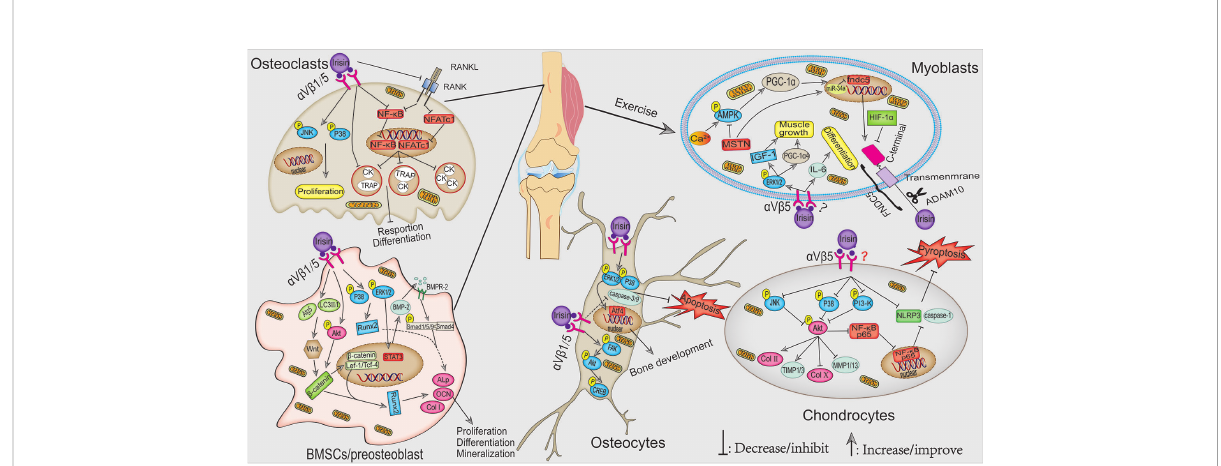
FIGURE 1 Potential mechanisms signaling pathways for the actions of irisin in musculoskeletal. During exercise, the elevated Ca 2+ in muscle cytoplasm- induced activation of the AMPK – PGC-1 a – FNDC5 axis is the main pathway for irisin synthesis. In addition, irisin, in turn, can stimulate muscle growth and myoblast differentiation via ERK1/2 – IGF-1/MSTN and IL-6 signaling pathways, respectively. Multiple pathways mediated exercise- induced irisin and r-irisin – activated osteoblast differentiation and mineralization, e.g., p38/ERK1/2, Akt- b -catenin, and Wnt- b -catenin – mediated activation of ALP/OCN/Col I pathways. In osteoclast, irisin induced its proliferation through activating the p38/JNK pathway. In addition, irisin also inhibited the NF- k B and NFATc1 levels in the nucleus, thus inhibiting the expression of osteoclast differentiation marker genes. As for osteocytes, irisin inhibited osteocyte apoptosis by inhibiting caspase-9 and caspase-3 expression, which probably through activating p38/ERK1/ 2. Furthermore, moderate exercise-activated irisin or r-irisin could alleviate OA by maintaining ECM stabilization and reducing in fl ammatory response through p38/JNK-Akt and PI3K/Akt/NF- k B signaling pathway, respectively.